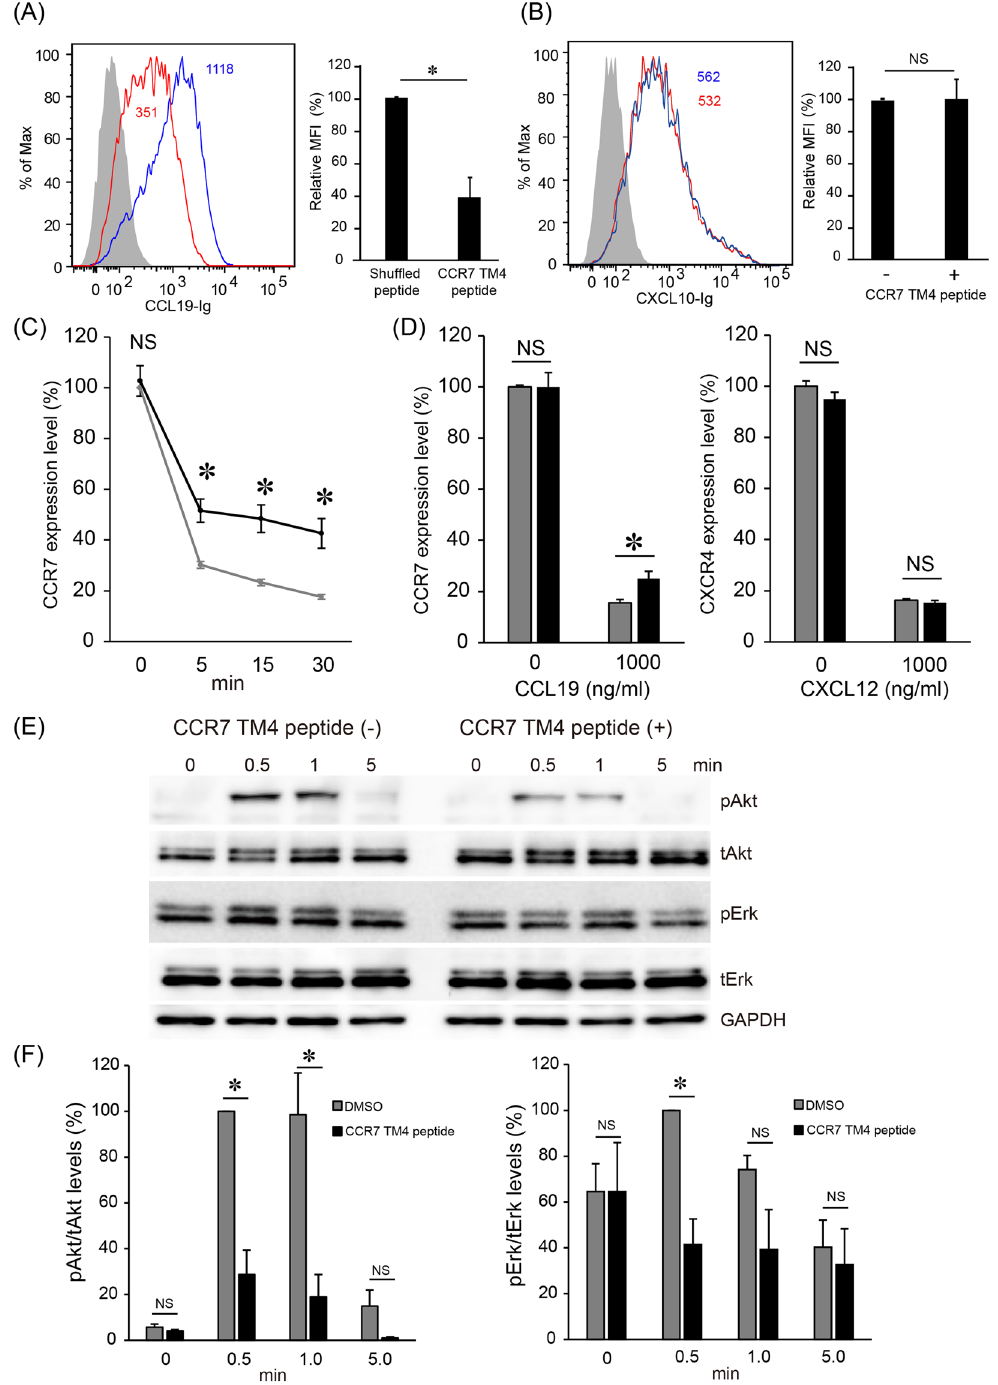
Figure 5. CCL19 binding, CCL19-induced CCR7 internalization and CCR7-dependent signaling are inhibited by the CCR7 TM4 peptide. ( A ) Flow cytometric analysis of CCL19-Ig (100 ng/ml) binding in H9 cells with the CCR7 TM4 peptide (red open histogram) or the shuffled peptide (blue open histogram). The gray-filled histogram shows the staining with control immunoglobulin. MFI is indicated on the histograms (left). The relative MFI of CCL19-Ig binding with the CCR7 TM4 peptide or the shuffled peptide is shown (right). Data are mean ± SD of three independent experiments. ( B ) Flow cytometric analysis of CXCL10-Ig binding with (red open histogram) or without (blue open histogram) the CCR7 TM4 peptide. The gray-filled histogram shows the staining with control immunoglobulin. MFI is indicated on the histogram (left). The relative MFI of CXCL10-Ig binding is shown (right). Data are mean ± SD of three independent experiments. ( C ) CCR7 expression levels after addition of 1 μ g/ml CCL19 were evaluated in the presence (black line) or absence (gray line) of the CCR7 TM4 peptide by flow cytometry using anti-CCR7 antibody. Data are mean ± SD of three independent experiments. ( D ) CCR7 (left) or CXCR4 (right) expression levels after addition of the indicated